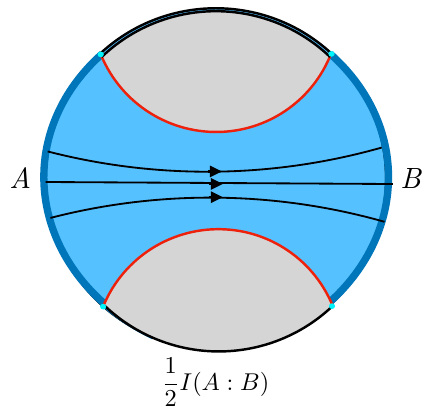
Figure 7 . A (cid:13)ow which gives 1